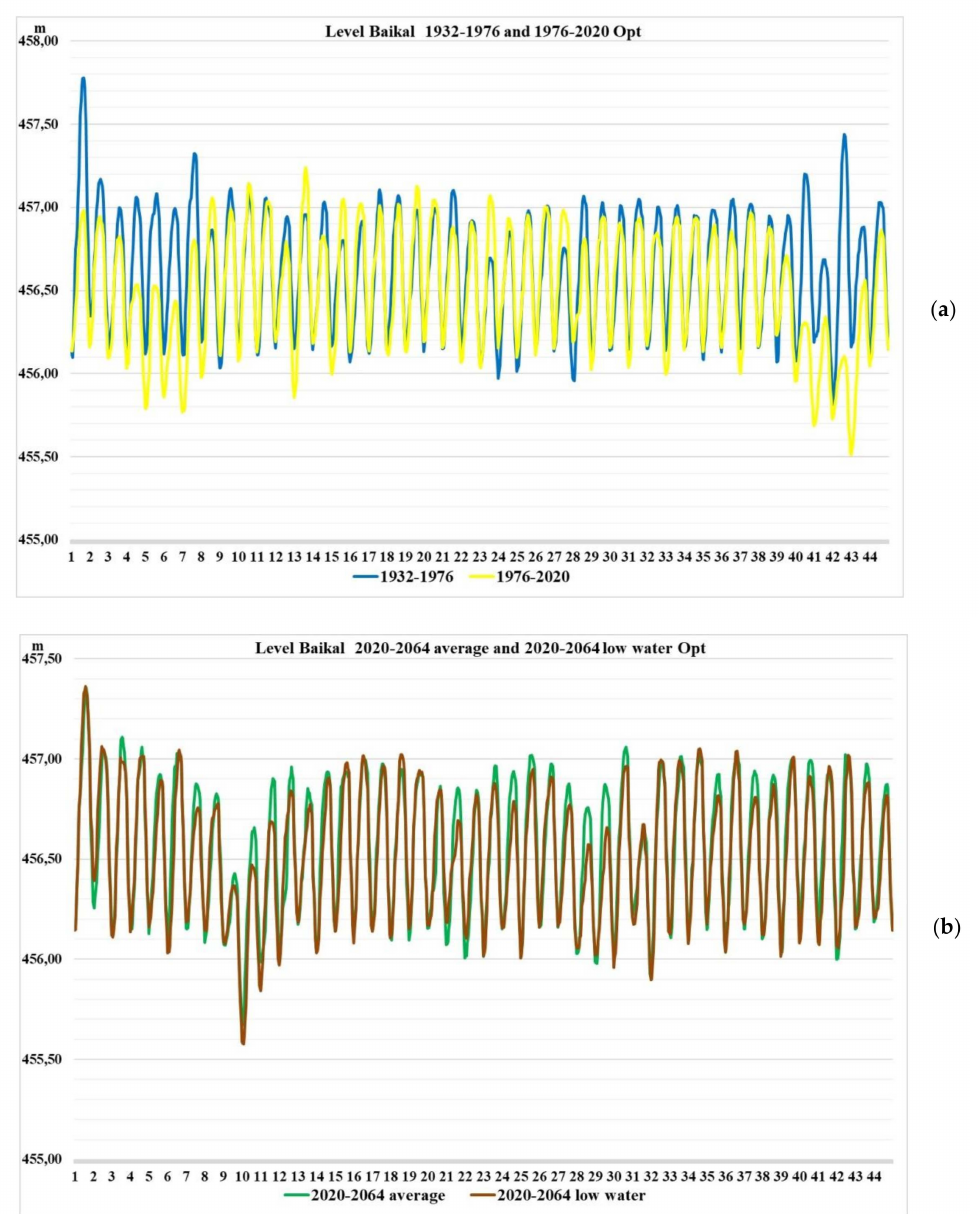
Figure 10. Baikal water level obtained as a result of WRC using optimization methods for